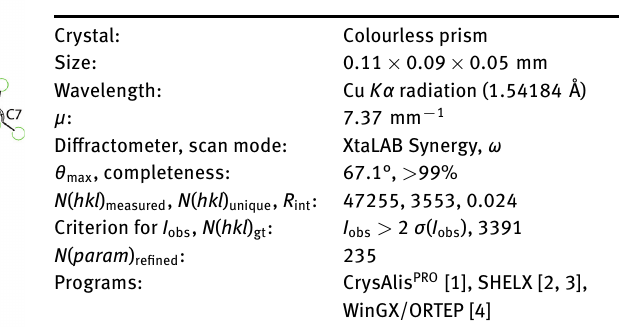
Table 1: Data collection and handling.